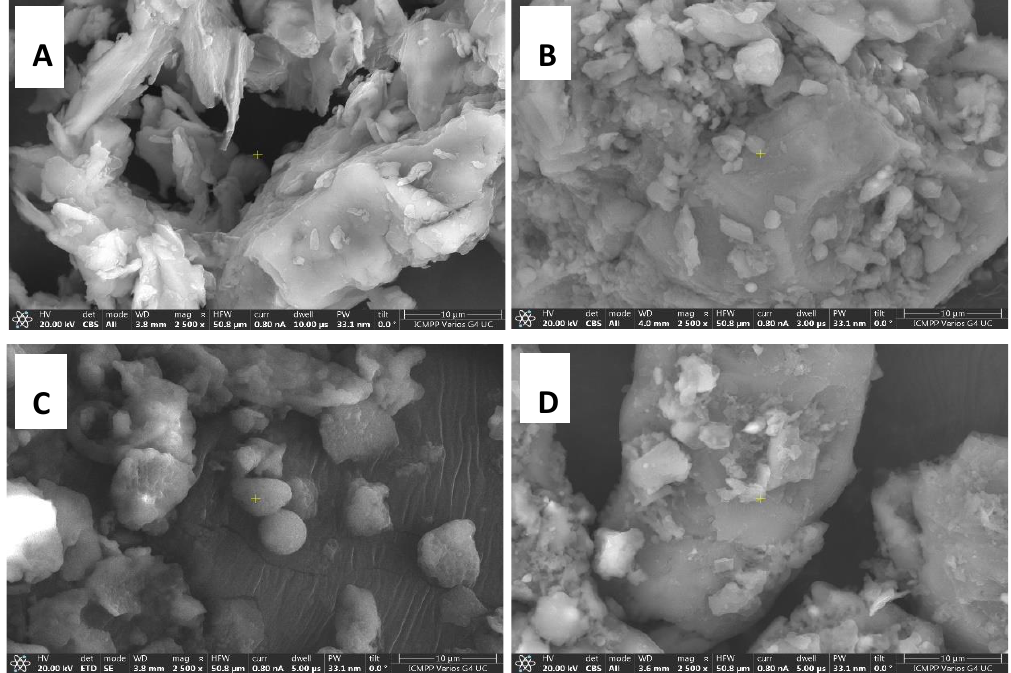
Figure 5. Representative SEM images of the waste type analyzed, 2500 × : ( A ) walnut shells; ( B ) peach kernels; ( C ) apricot kernels; ( D ) olive